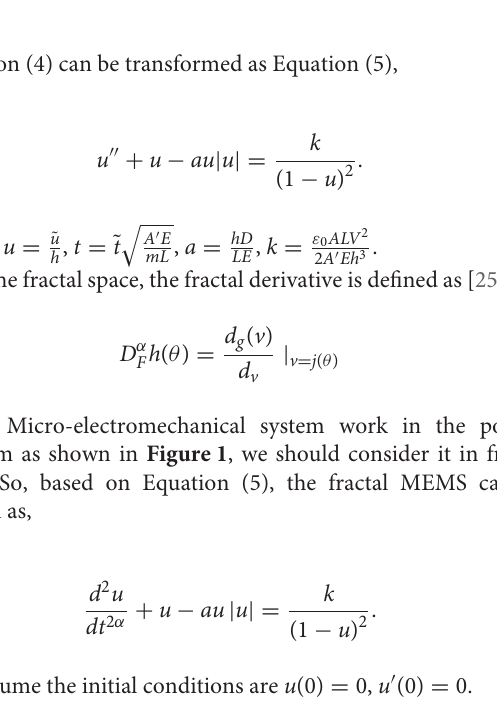
FIGURE 3 | Pull-in stability for α =